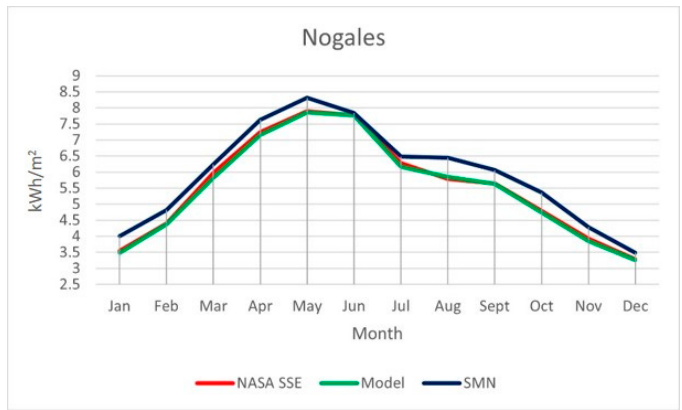
Figure 4. Comparison between the SMN, NASA SSE, and the model for the station of Hermosillo.